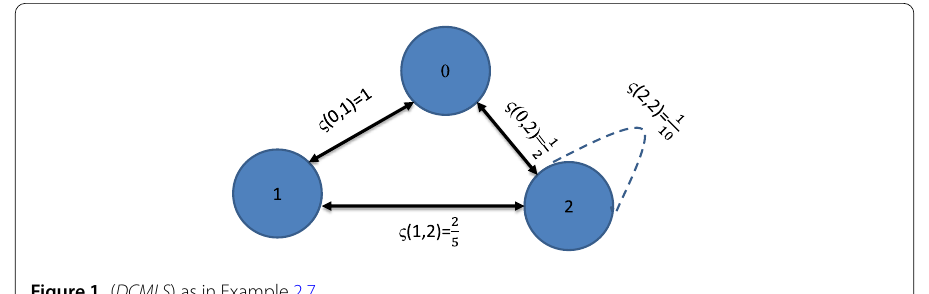
Figure 1 ( DCMLS ) as in Example